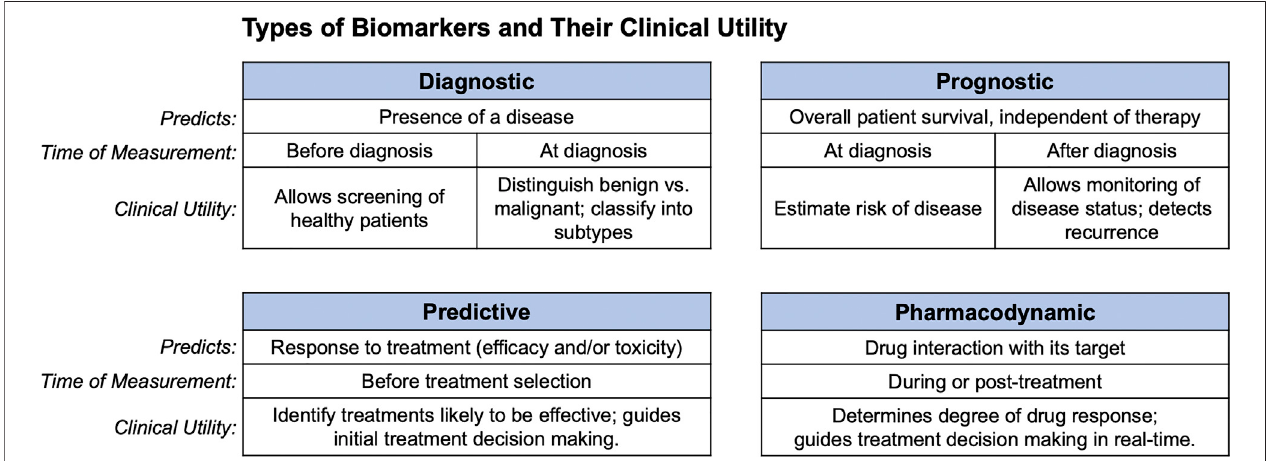
FIGURE 1 | Clinical uses of biomarkers. Diagnostic, prognostic, predictive, and pharmacodynamic biomarkers are shown along with what each predicts, and the clinical setting in which they can be used.